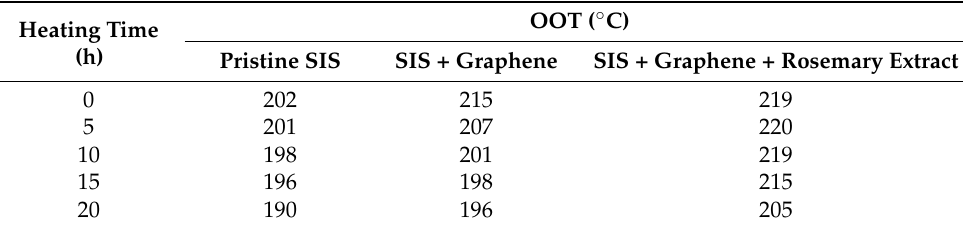
Table 1. Onset oxidation temperatures for SIS samples modified with graphene (1 wt%) and rosemary extract (0.5